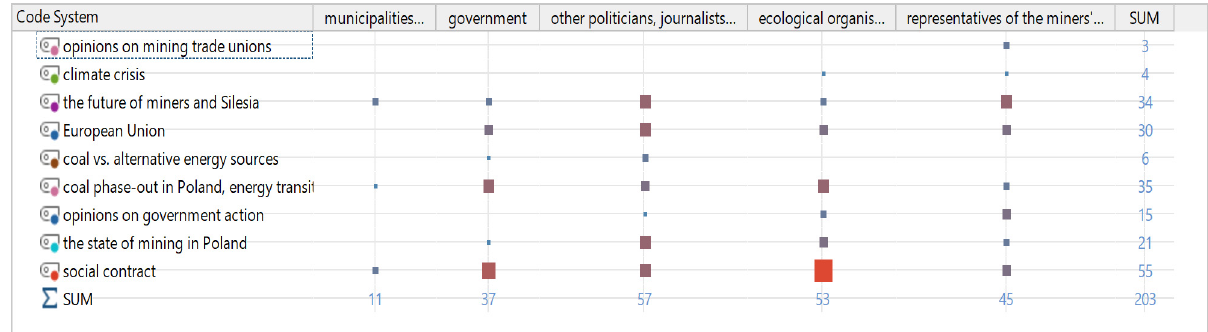
Figure 4. The matrix representing the codes and the statements of the actors in the discourse on the energy transition in Poland. Source: author’s own compilation using MAXQDA.